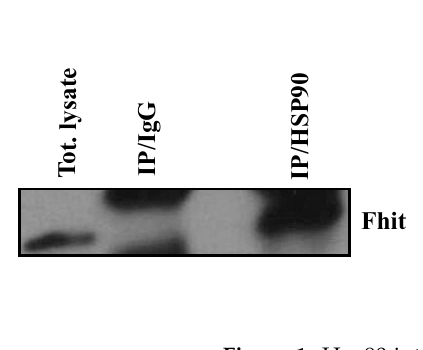
Figure 1. Hsp90 interacts with Fhit. ( A ) Proteins derived from Colo38 were immunoprecipitated using an agarose-conjugated antibody against IgG or Hsp90, and immunoprecipitates were separated on SDS-PAGE and subsequently blotted with Fhit and Hsp90 antibodies. ( B ) Fhit protein expression was evaluated with normal melanocyte and melanoma cancer cells via W.B. with an antibody against Fhit. Gapdh and B-actin were used as loading controls.